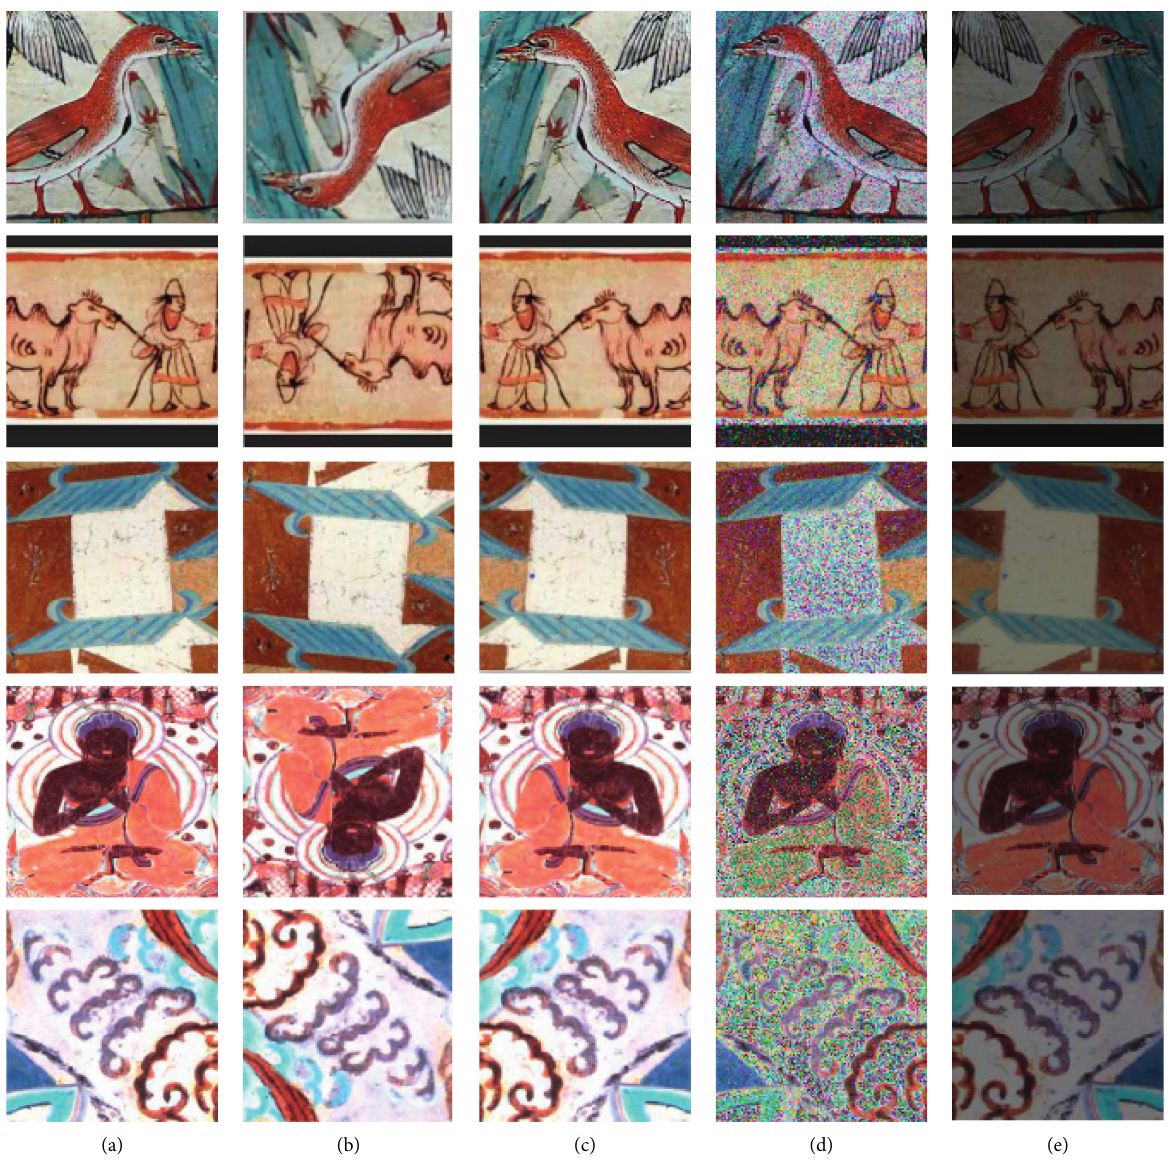
Figure 4: Data enhancement image. (a) Original image. (b) Upside down. (c) Flipped. (d) Noise(a). (e) Darken.